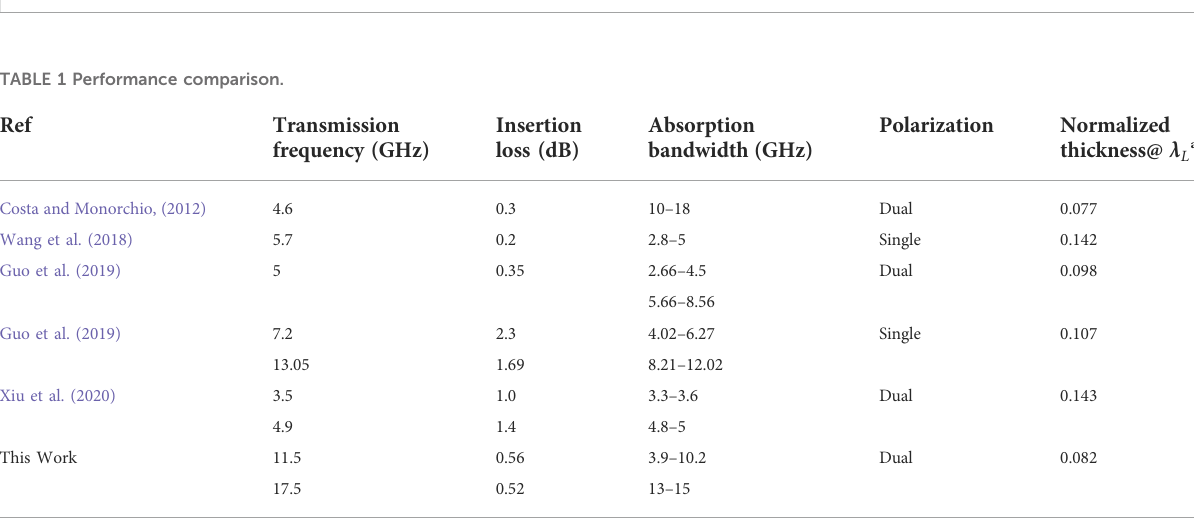
Oblique-angle dependence of cascaded metasurface. Transmission coef fi cients and absorptivity under (A,C) TE polarization, (B,D) TM